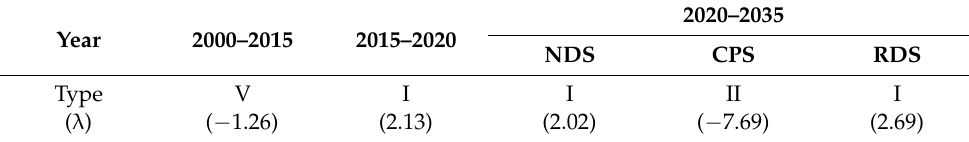
Table 9. Coupling relationship type in Deqing,